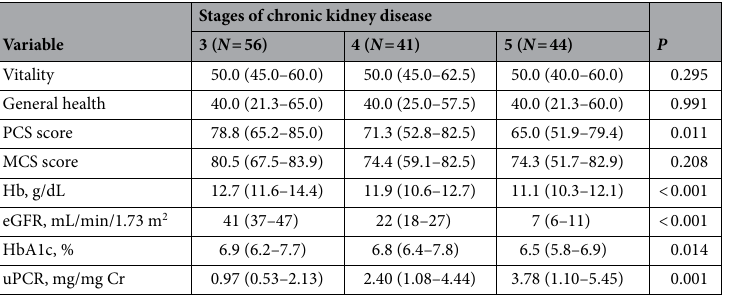
Table 1. Baseline characteristics of patients with diabetic kidney disease. Values are expressed as the median (interquartile range) or percentage, as appropriate. The eight SF-36 scales are as follows: physical functioning (PF), role limitation caused by physical problems (RF), bodily pain (BP), general health (GH), vitality (VT), social functioning (SF), role limitation caused by emotional problems (RE), and mental health (MH). BMI body mass index, CCI Charlson Comorbidity Index, CHF congestive heart failure, COPD chronic obstructive lung disease, DBP diastolic blood pressure, DM diabetes mellitus, eGFR estimated glomerular filtration rate, IPAQ International Physical Activity Questionnaire, Hb hemoglobin, MCS mental component summary, MI myocardial infarction, PAOD peripheral artery occlusive disease, PCS physical component summary, PSQI-K Korean version of the Pittsburgh Sleep Quality Index, SBP systolic blood pressure, SF-36 Short Form 36 Health Survey Questionnaire, uPCR urine protein-to-creatinine